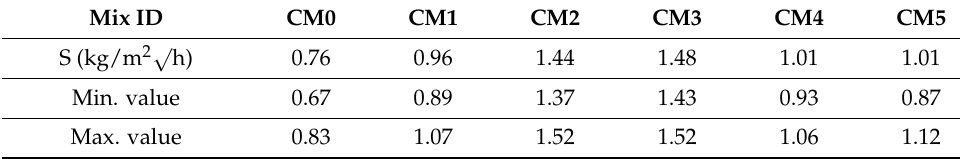
Table 8. Sorption coefficient of specimens with WBA and reference